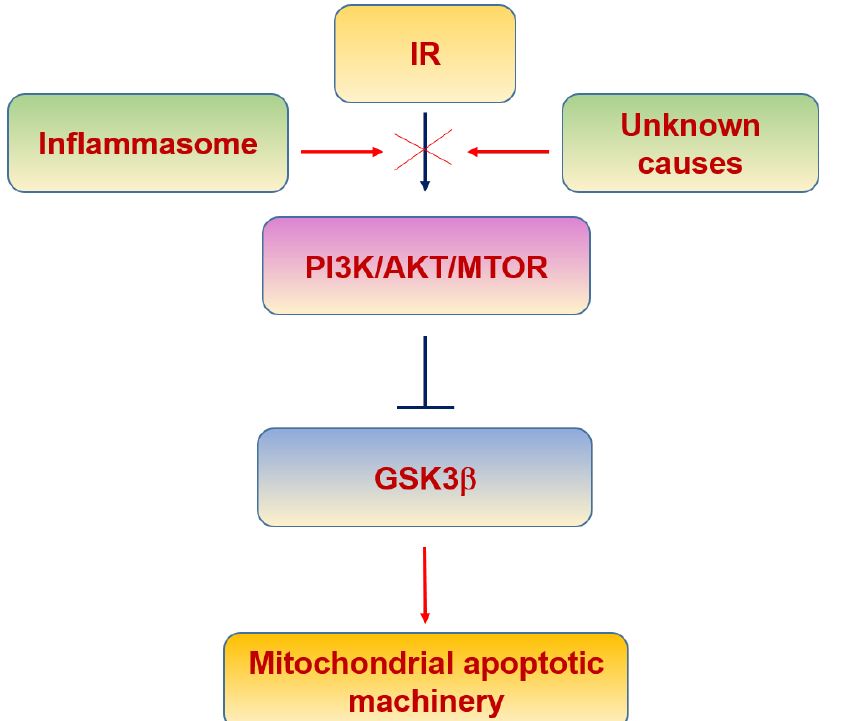
Figure 7. Insulin resistance and mitochondria.